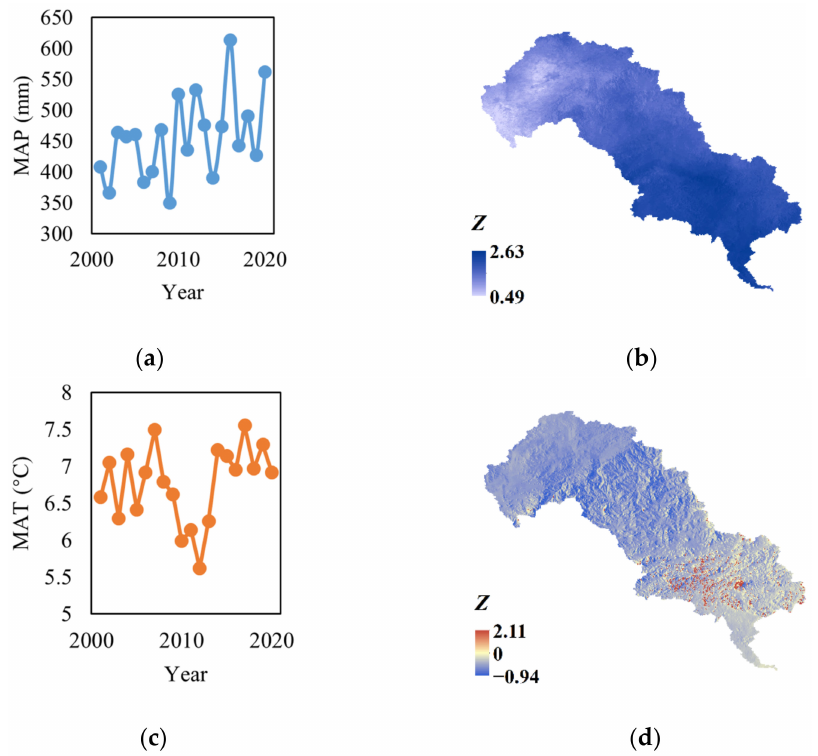
Figure 12. Trend of climate factors ( a ) MAP, ( b ) M–K test of MAP, ( c ) MAT, ( d ) M–K test of